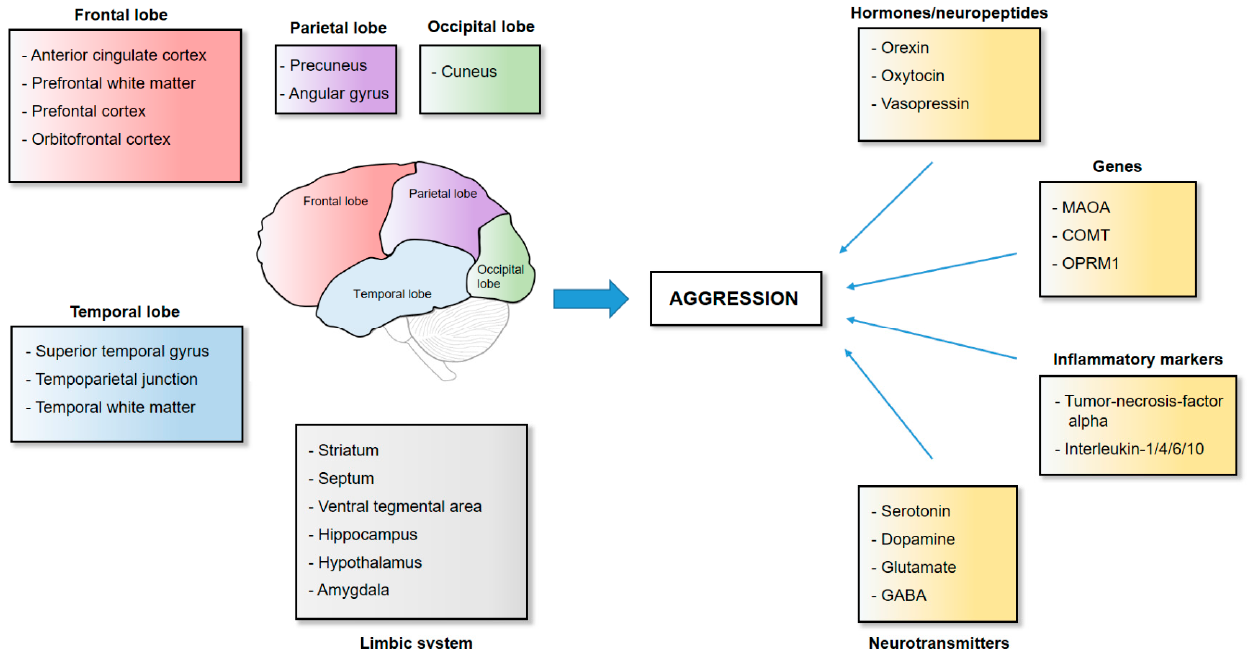
Figure 1. Neuroanatomical and genetic basis of aggression in humans and animals. Aggressive behavior is mediated by several brain regions originating from the frontal, parietal, occipital, or temporal lobe and from regions part of the limbic system. Other factors that influence human and animal behavior include genes, inflammatory markers, hormones, neuropeptides, and neurotransmitters.